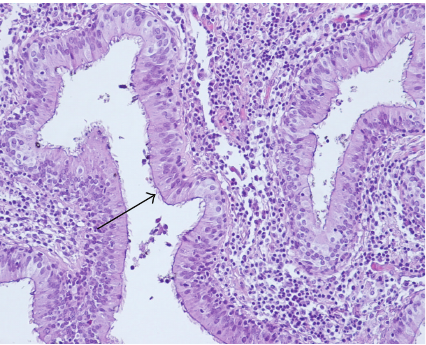
Figure 5: Hematoxylin and eosin stained photomicrograph (mag- nification × 200) shows a portion of the cyst wall, composed of pseudostratified respiratory epithelium